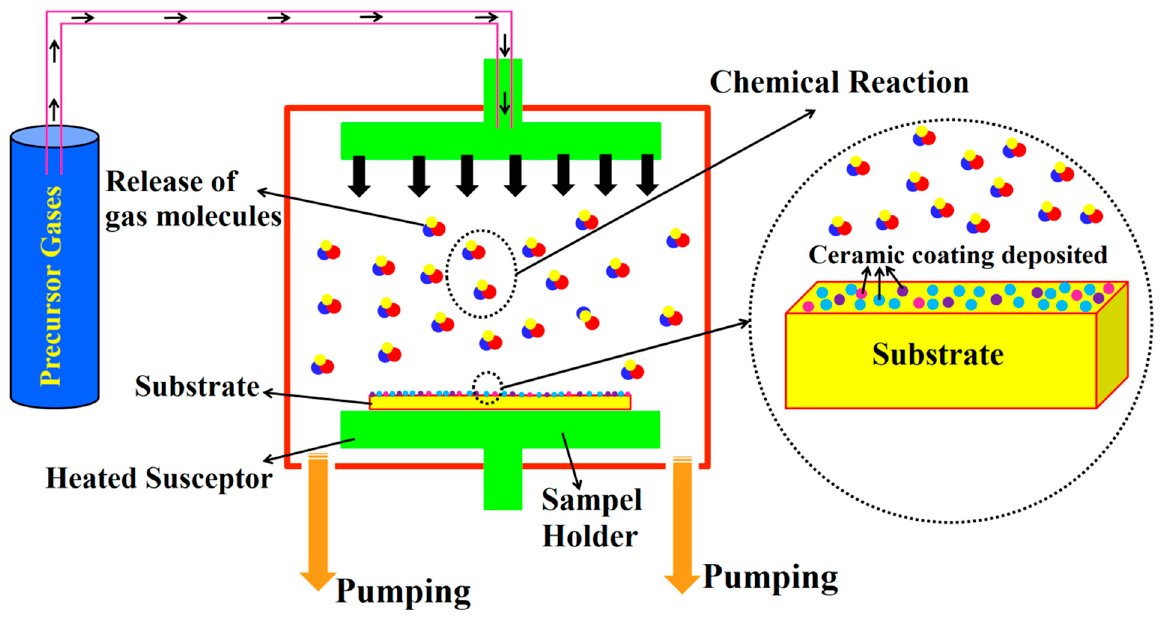
Figure 1. An example of a CVD system for the deposition of ceramic nanocomposite coatings.